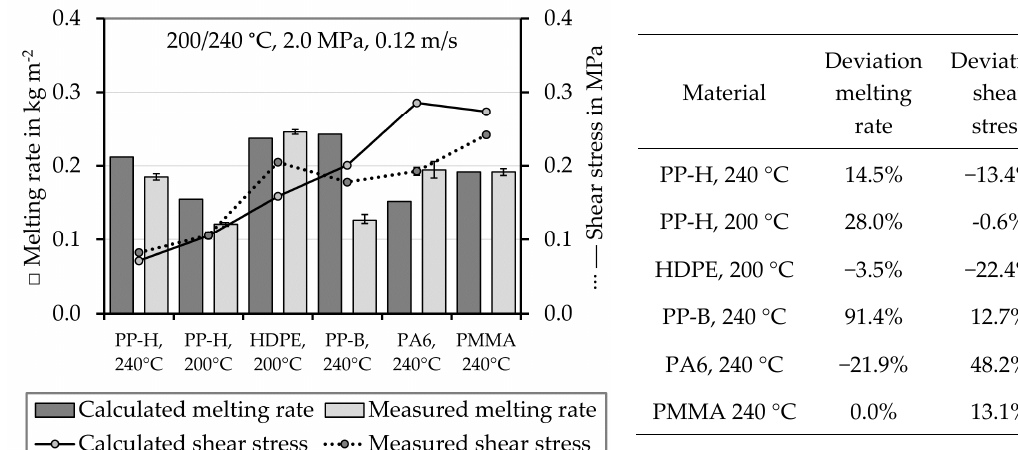
Figure 5. Measured and calculated melting rates of the pure bulk materials and the deviations between the experimentally obtained and the calculated melting rate and shear stress values. PP-H stands for PP-H, grade A. Positive deviations mean that the calculated value is higher than the experimental determined value.